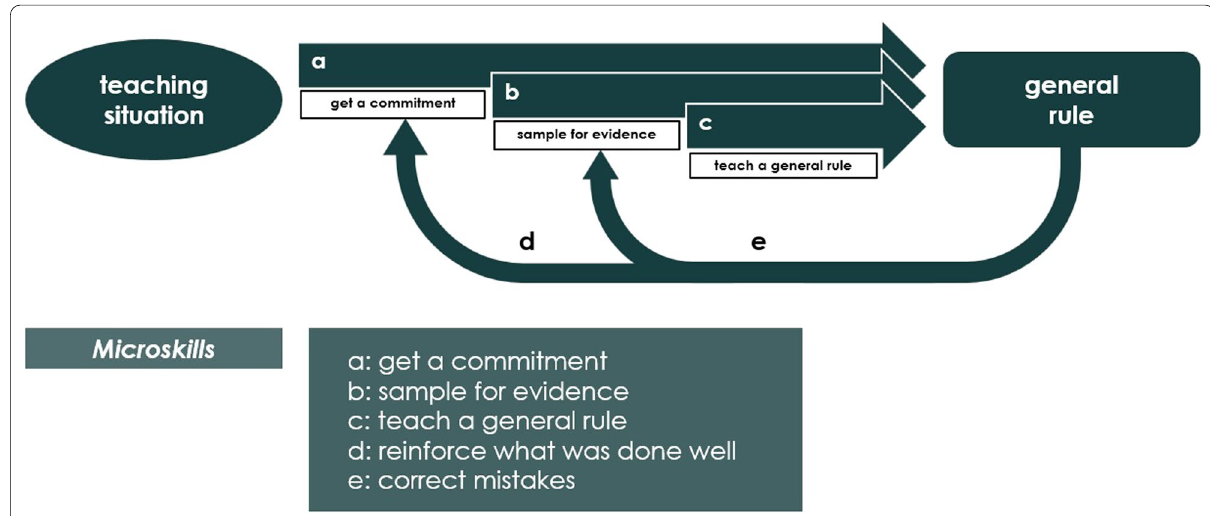
Fig. 1 Technique of the five‑step Microskills Model [25,